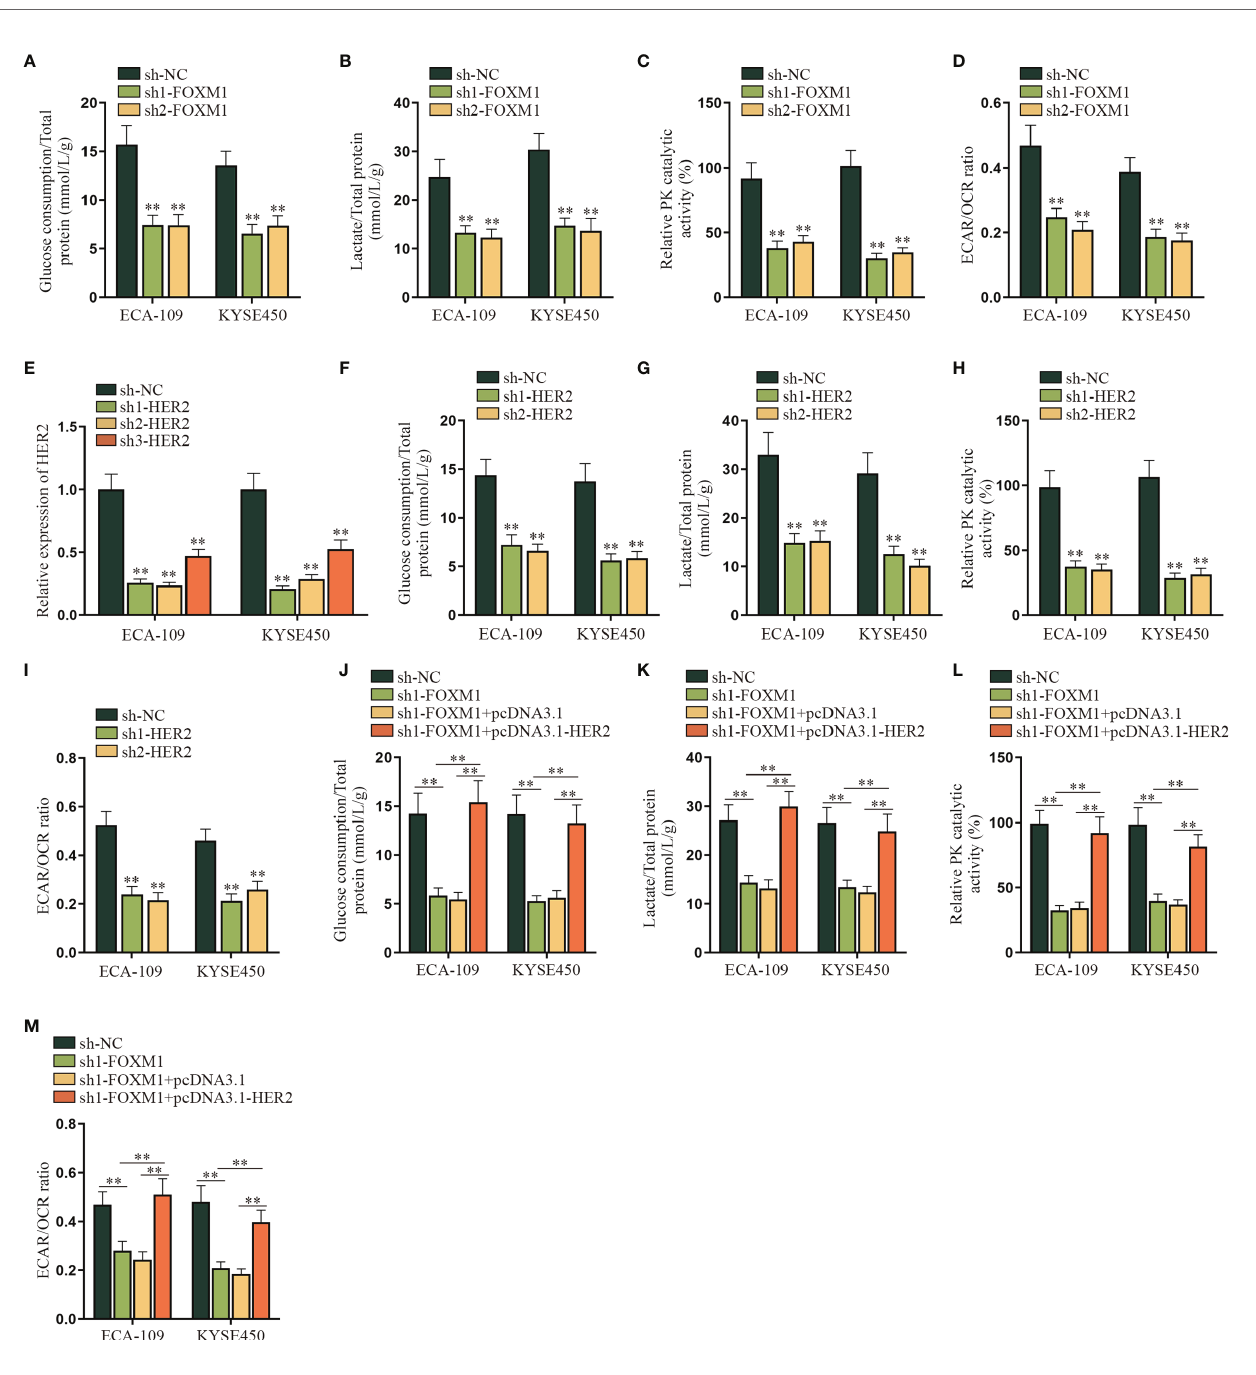
FIGURE 4 | FOXM1 promotes the aerobic glycolysis of ESCC cells via up-regulating HER2. (A – I) The impact of sh-FOXM1 and sh-HER2 transfection on the aerobic glycolysis of ESCC cells was respectively evaluated including the measurement of glucose consumption, total lactate protein, relative PK catalytic activity, and the ECAR/ OCR ratio. (J – M) Experimental groups were divided into sh-NC, sh1-FOXM1, sh1-FOXM1+pcDNA3.1, and sh1-FOXM1+pcDNA3.1-HER2 groups, and glucose consumption, total lactate protein, relative PK catalytic activity, and the ECAR/OCR ratio were respectively examined by qRT-PCR in different groups. ** p <